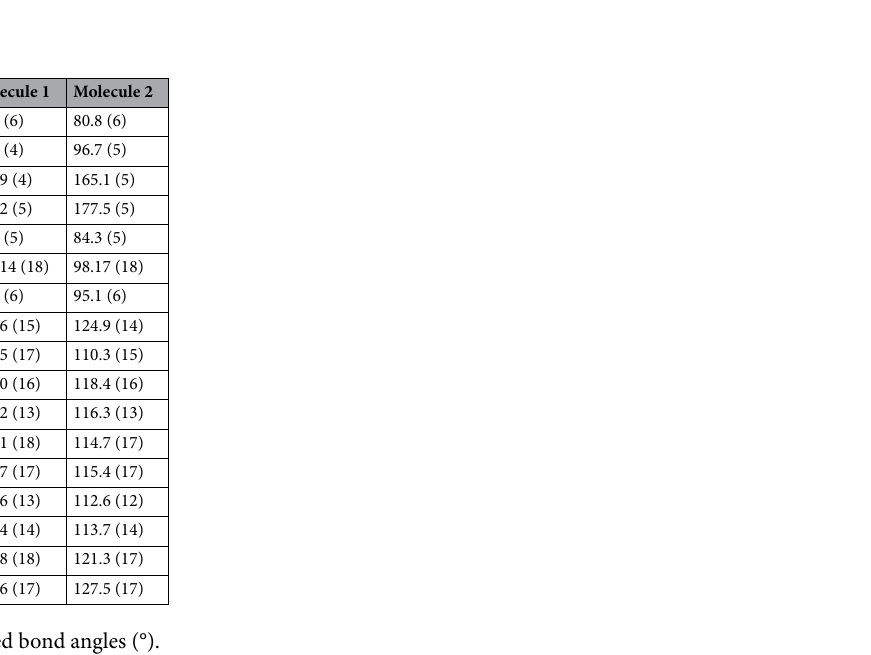
Table 3. Selected bond length (Å) Molecule 2 corresponds to the molecule labeled with prefix ‘A’ in Fig. 1.